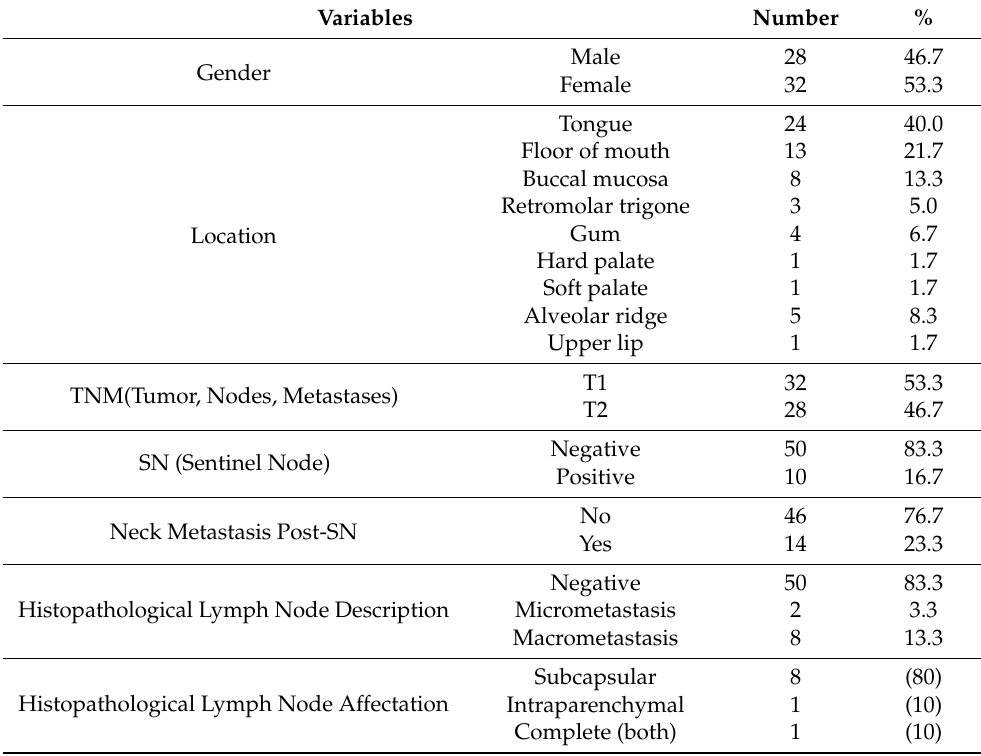
Table 1. Descriptive summary of the qualitative variables of the patients included in the study.